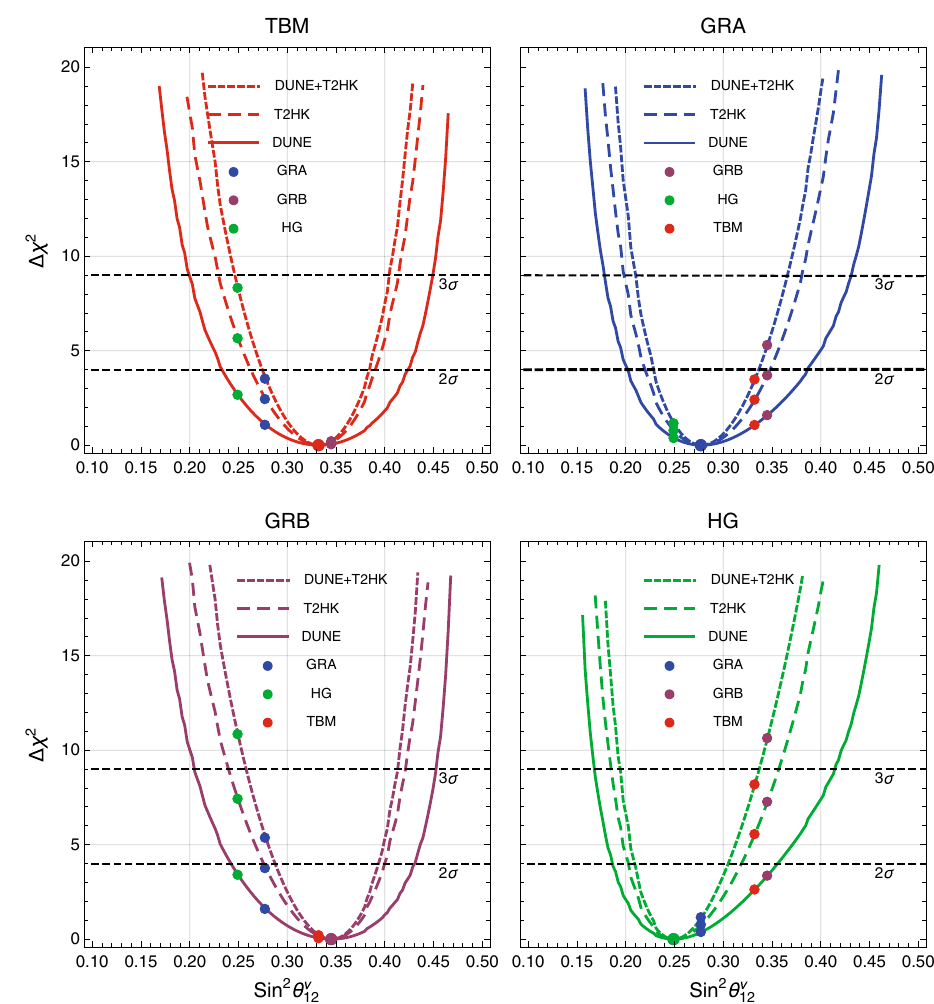
Fig. 3 Sensitivities of the experiments DUNE, T2HK and their combined (prospective) data to the symmetry form parameter sin 2 θ ν allowing to 12 distinguish between the TBM, GRA, GRB, and HG symmetry forms under the assumption that one of them is realised in Nature. In the top left and right panels the assumed true symmetry forms are respectively = 1 / 3) and GRA TBM (sin 2 θ ν 12 = 0 . 276), while in the (sin 2 θ ν 12 bottom left and right panel these forms are GRB = 0 . 345) and HG (sin 2 θ ν 12 = 0 . 25). See text for (sin 2 θ ν 12 further details. (From Ref.